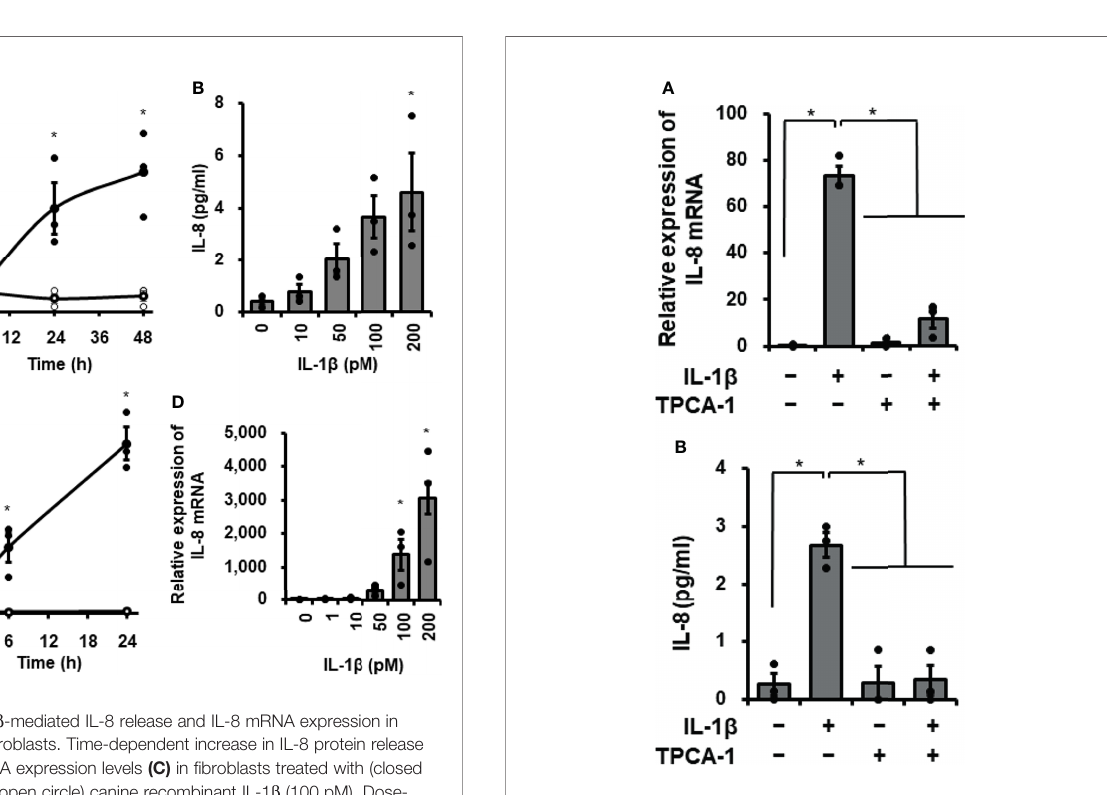
FIGURE 2 | Effect of the NF- k B inhibitor TPCA-1 on IL-1 b -mediated IL-8 mRNA expression. Canine cardiac fi broblasts were pretreated with or without TPCA-1 (10 µM) for 1 h and subsequently stimulated with or without IL-1 b (100 pM) for 24 h. After stimulation, IL-8 mRNA expression levels (A) and the release of IL-8 (B) were determined. HRPT1 was used as an internal standard and the expression levels of IL-8 mRNA in IL-1 b - stimulated fi broblasts were compared with the expression at 0 h. Results have been represented as mean ± standard error (SE) from biological triplicates. *P